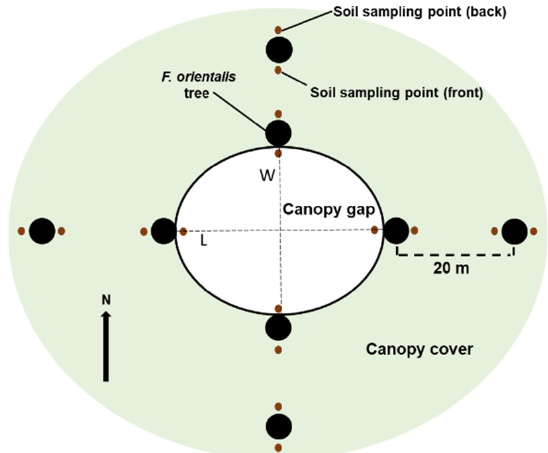
Figure 1. Sketch of location of the sampling points in the gap (white area) and adjacent intact forest (light green area). Large black circles indicate the sampled trees, small brown circles the soil core position, in the front and back of the selected trees. Dashed L and W lines indicate the distances among stems used for ellipse calculation. All gaps were oriented with the short distance of the ellipse always parallel to the north direction.